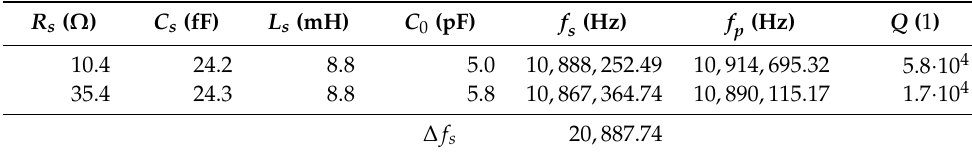
Table 3. Equivalent circuit parameters for QCM with B-Au layer.